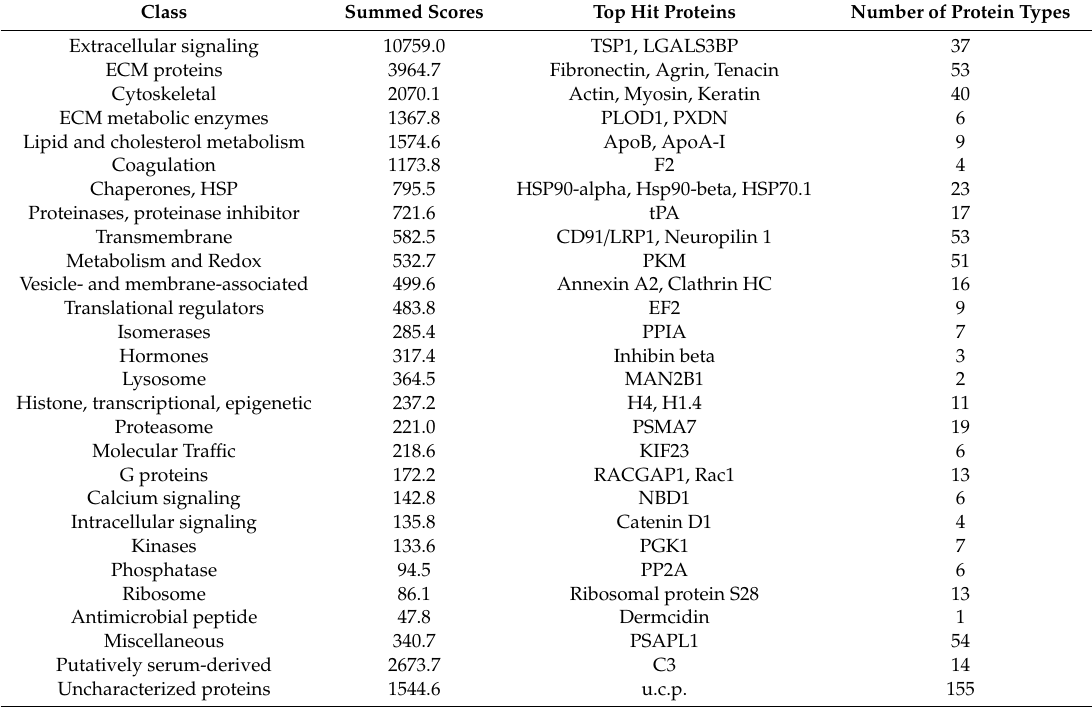
Table 2. The proteome of EVs released from PC-3